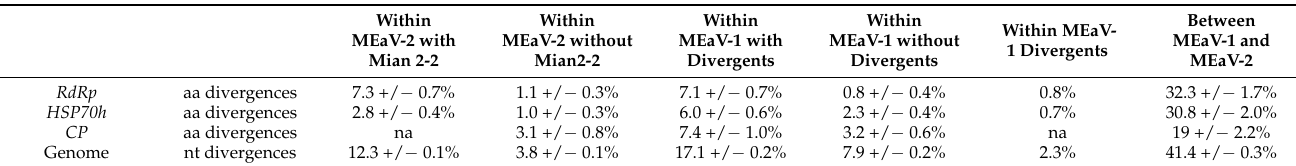
Table 7. Intergroup and intragroup average pairwise divergence and standard deviation calculated for the three taxonomi- cally relevant proteins ( RdRP, HSP70h and CP ) and for the nearly complete genomes.